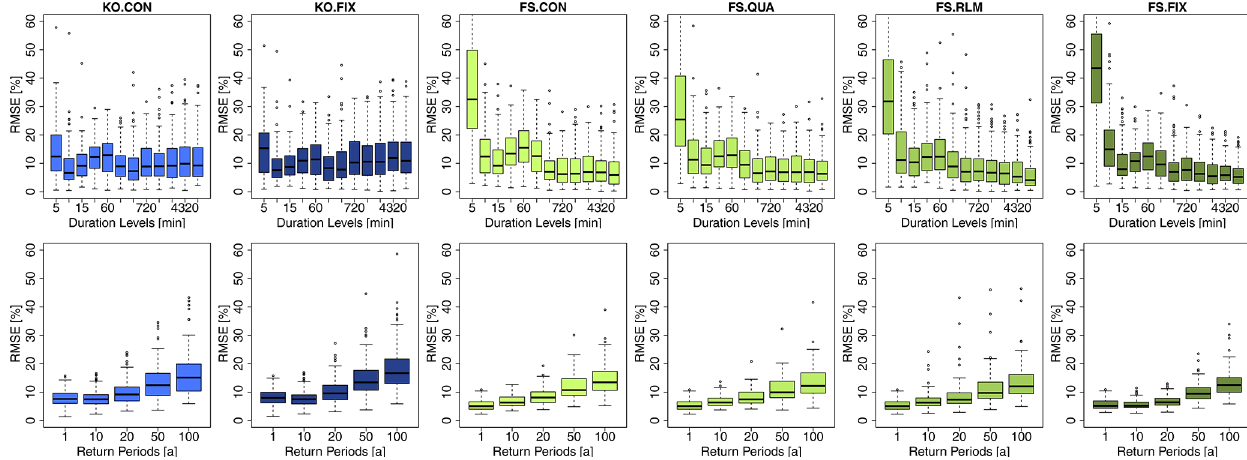
Figure 10. RMSE (%) performance of the given generalisation methods over all the long series (LS) in comparison to the duration-specific GEV quantiles grouped in the upper row for different duration levels (calculated per station over return periods, T[a]), and the lower row for different return periods (calculated per station over duration levels). The overview of the methods shown here is given in Table 5.